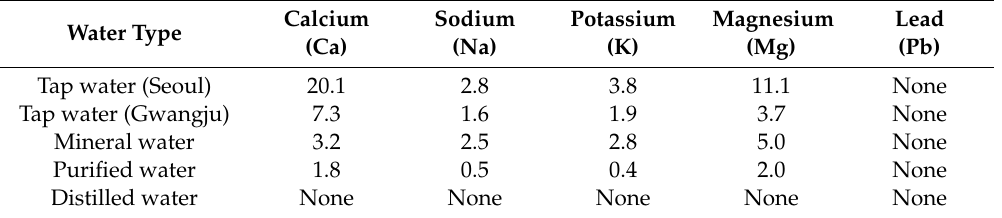
Table 3. Mass concentration of mineral in each water type (unit: mg /